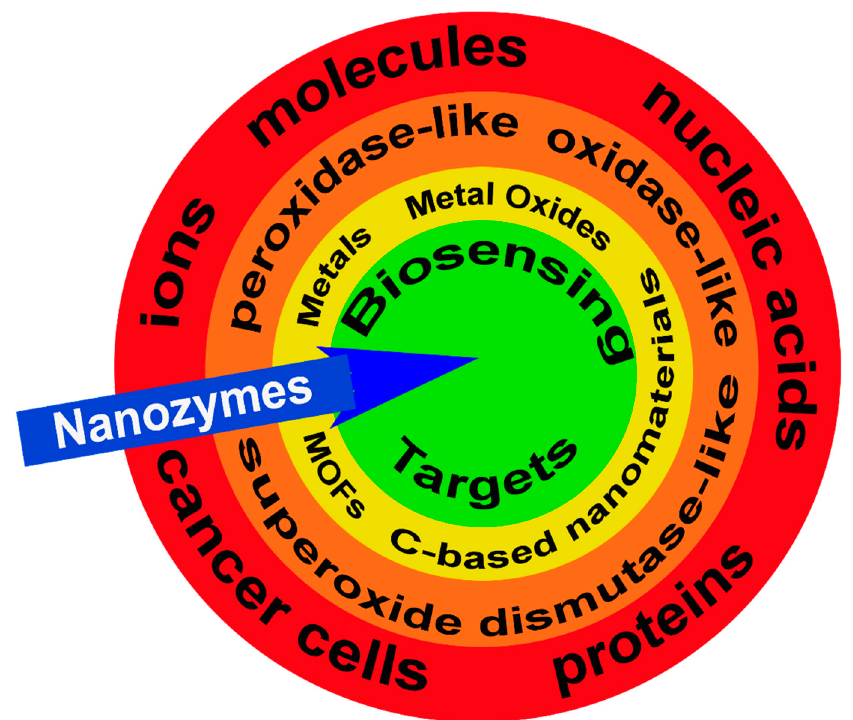
Figure 1. Nanozymes and biosensing targets. Examples of potential targets for nanozymes (blue arrow) including ions, molecules, nucleic acids, proteins, and cancer cells (red band). There are three categories of nanozymes grouped by their functional enzyme-mimicking capacity including, peroxidase-like, oxidase-like, and superoxide dismutase-like (orange band) with the active sites generated by metals, metal oxides, metal-organic frameworks (MOFs), and carbon (C)-based nanomaterials (yellow band). Collectively, these features attract and facilitate the enzymatic reaction at the nanozyme target biosensing target (green circle).